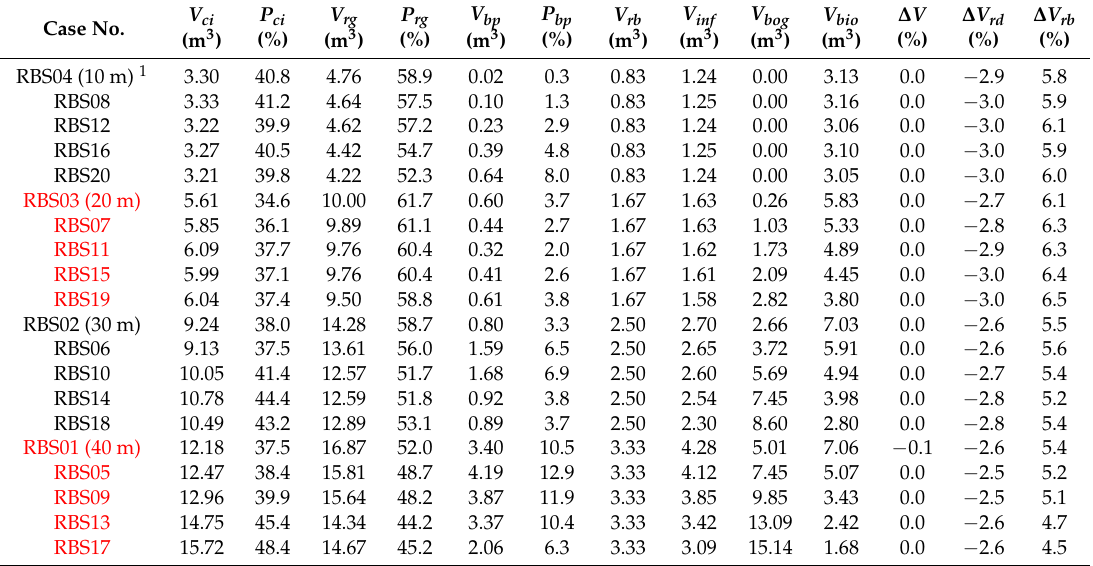
Table 5. Simulation results of road-bioretention cases (grouped by L